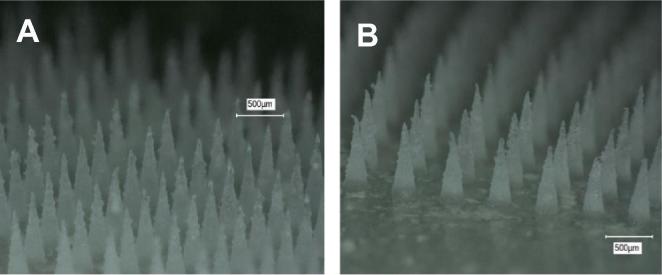
Micrographs exemplify the sharp tips of a 58 kDa PVP 19 × 19 MN array (A) and of an 11 × 11 MN array prepared from Gantrez® S-97 (B).